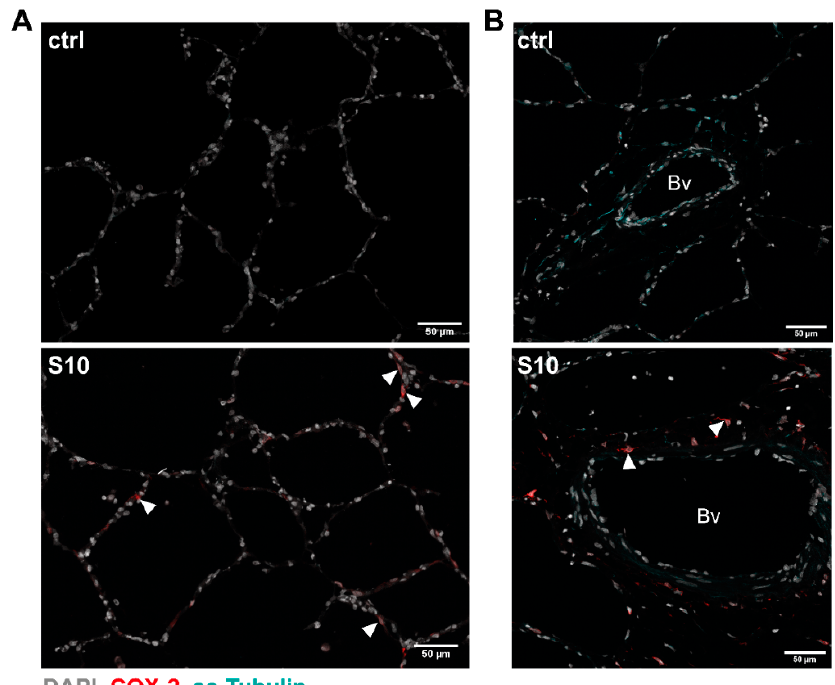
Figure 3. COX-2 induction in distal alveolar tissue and blood vessels in S. suis infected PCLS. PCLS